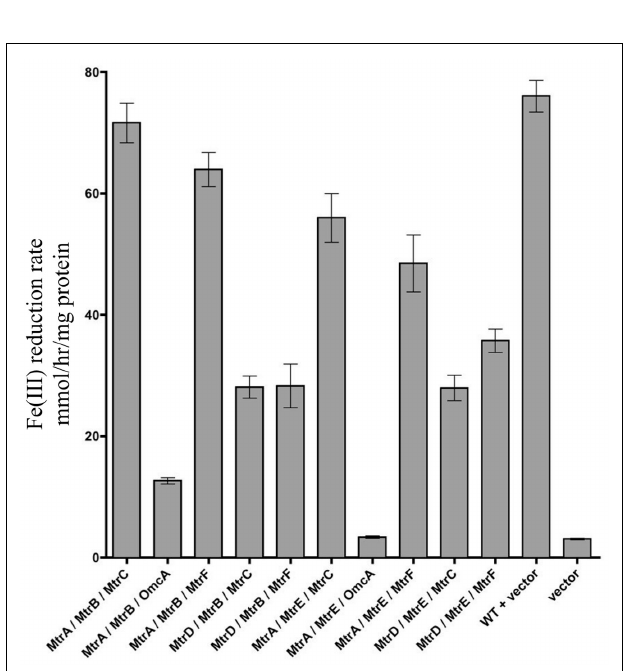
FIGURE 5 | Iron(III) citrate reduction by all possible functional Mtr modules. Iron(III) citrate reduction rate of Δ Mtr/ Δ mtrB / Δ mtrE complemented strains. Rates are reported in millimolar per hour per microgram